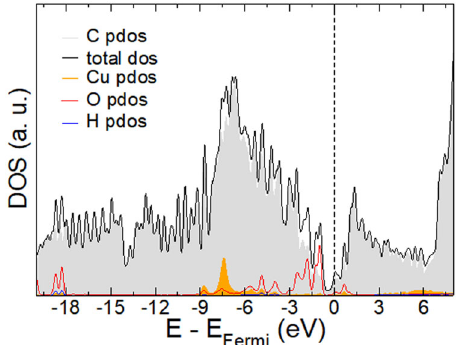
Fig. 5 Analysis of electronic properties of Cu-N-rGO sample. Density of states (DOS) and projected density of states (PDOS) for Cu-N-rGO in the con fi guration reported in Fig. 3f. The black lines correspond to the total DOS, the grey lines to the DOS projected on C atoms, the orange line to DOS projected on Cu atom, blue and red lines represent the DOS projected on H and O atoms respectively; the thin dashed vertical line corresponds to the position of Fermi Energy.